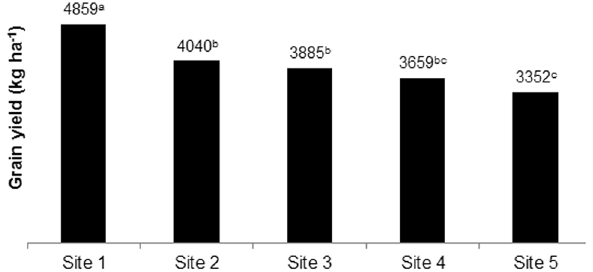
Fig. 3 Grain yield of malting barley as influenced by location at Lemu-Bilbilo in southeastern Ethiopian